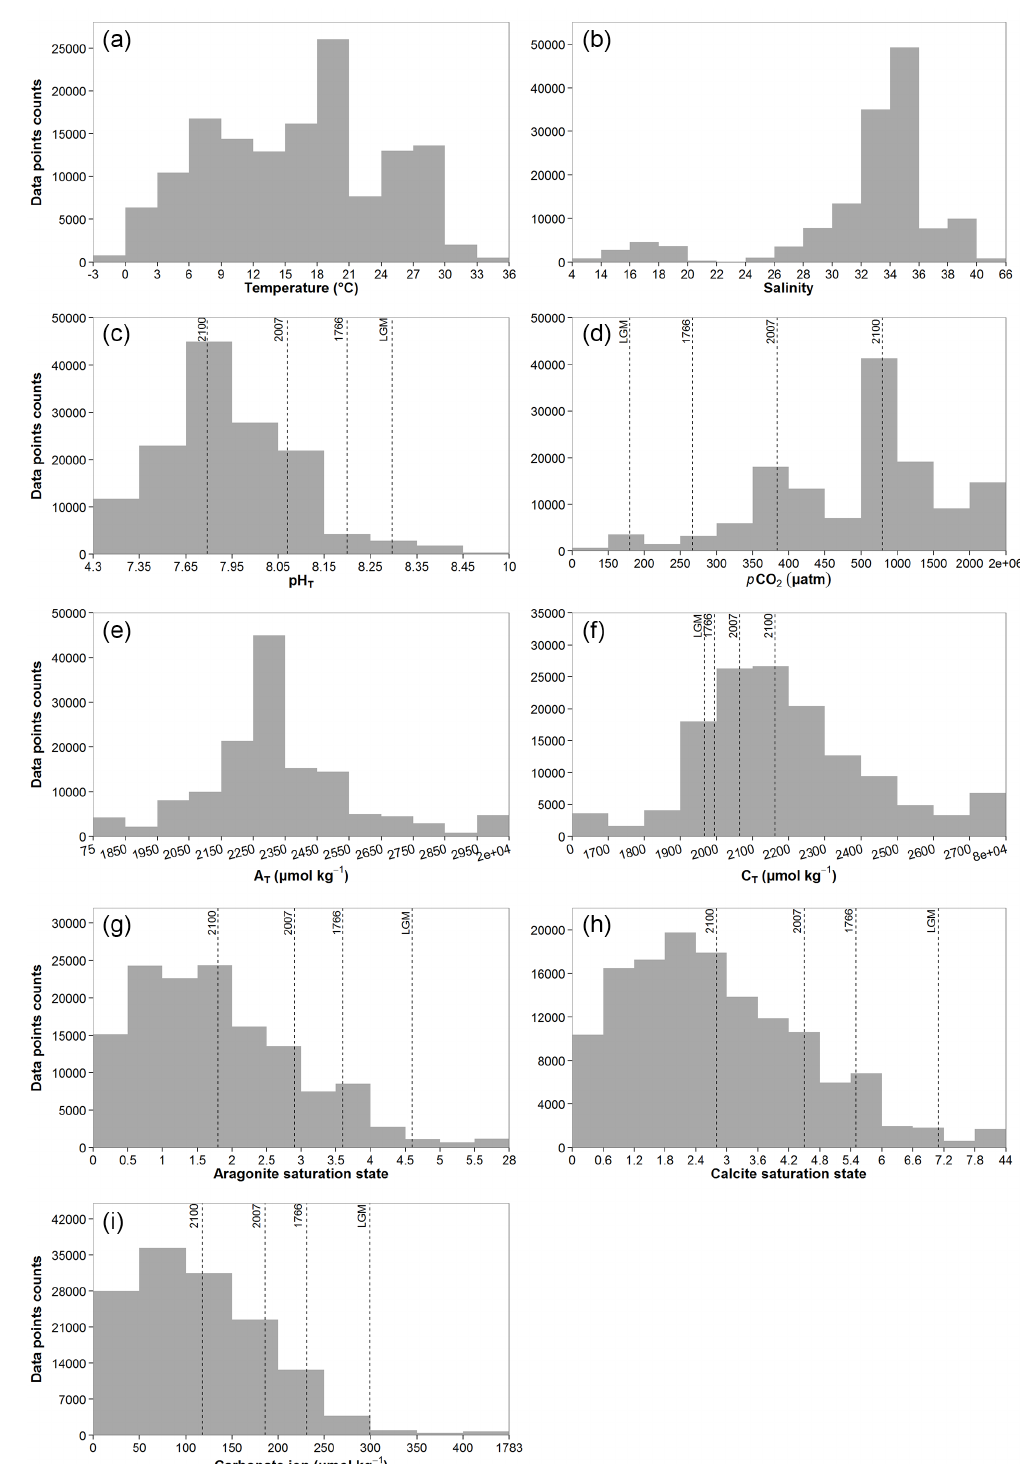
Figure 8. (a) Temperature, (b) salinity, (c) pH T , (d) p CO 2 , (e) A T , (f) C T , (g) aragonite saturation state, (h) calcite saturation state and (i) carbonate ion coverage in the compilation. The dashed vertical lines indicate the average open-ocean surface values, during the Last Glacial Maximum (LGM), 1766, 2007 and 2100 (see the values in Table 1.1 of Gattuso and Hansson, 2011).